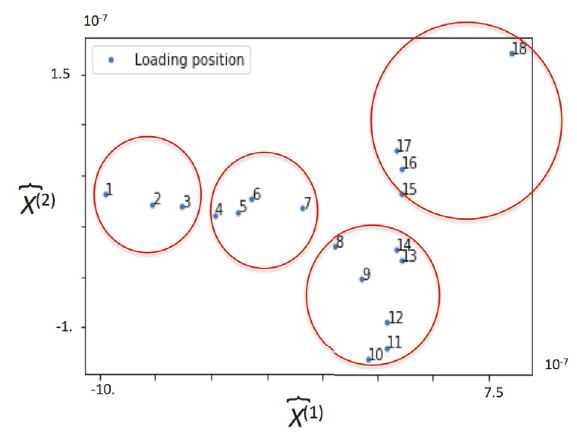
(⏞⏞⏞⏞⏞⏞⏞ ⏞⏞⏞⏞⏞⏞⏞ 𝑋 (1) , 𝑋 (2) ) submitted to the k-means 𝑖 𝑖